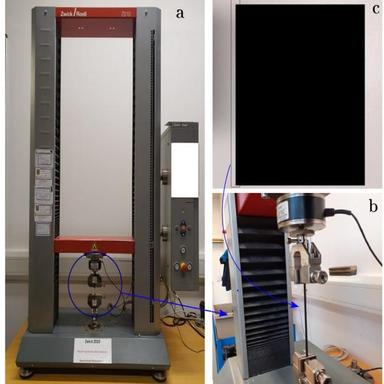
A complete experimental set-up: (a) The main framework of the Zwick/Roell Z010 machine highlighting the gripping section in a circle, (b) A closeup look of the gripping system along with an elongated specimen, (c) A large 3D printed rectangular EPU40 sheet (black colour) of 100 mm × 120 mm × 1 mm (width × length × thickness).